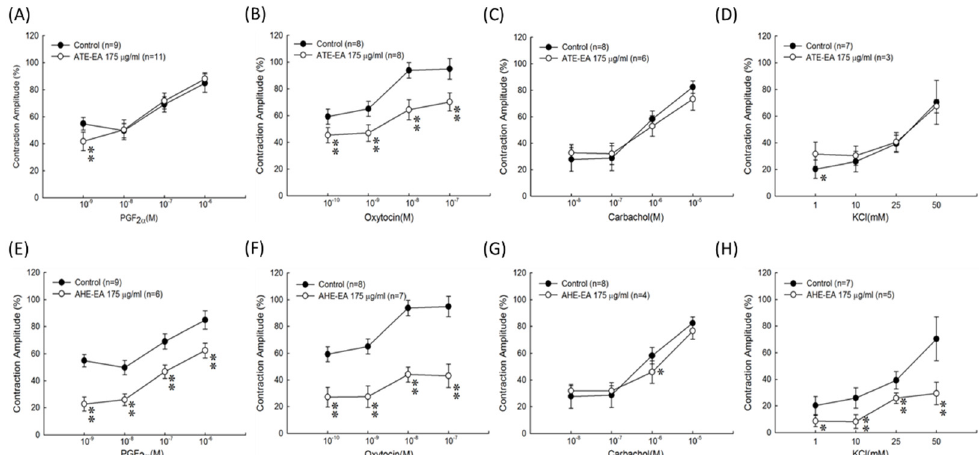
Figure 3. Effects of ATE-EA given cumulatively on the PGF 2 α -induced ( A ), oxytocin-induced ( B ), carbachol-induced ( C ), and KCl solution-induced ( D ) contractions of isolated rat uterus. AHE-EA given cumulatively on the PGF 2 α -induced ( E ), oxytocin-induced ( F ), carbachol-induced ( G ), and KCl solution-induced ( H ) contractions of isolated rat uterus. Data represent mean values ± SD. * p < 0.05, ** p < 0.01 compared with control. PGF 2 α , prostaglandin F2 alpha; ATE-EA, ethyl acetate fraction of adlay testa ethanolic extract; AHE-EA, ethyl acetate fraction of adlay hull ethanolic extract.